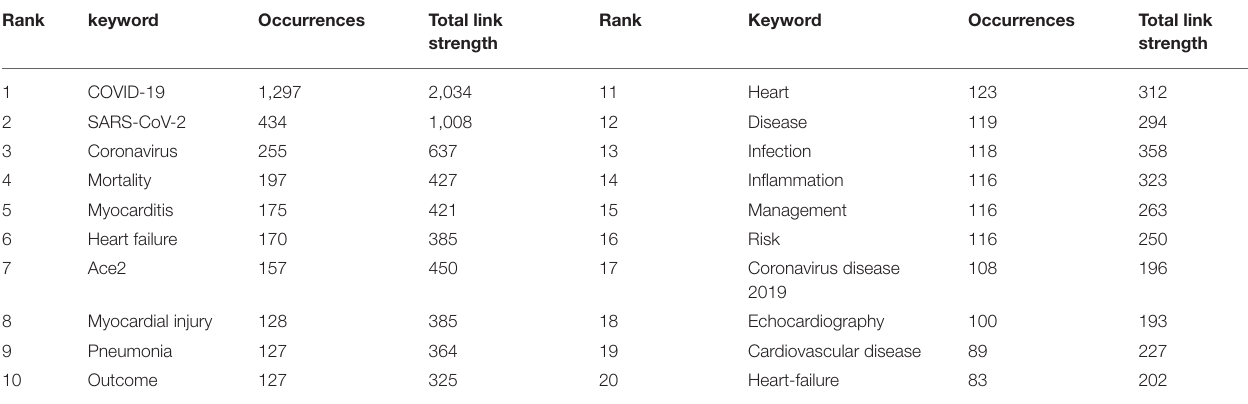
TABLE 7 | Top 20 keywords related to COVID-19-mediated cardiac